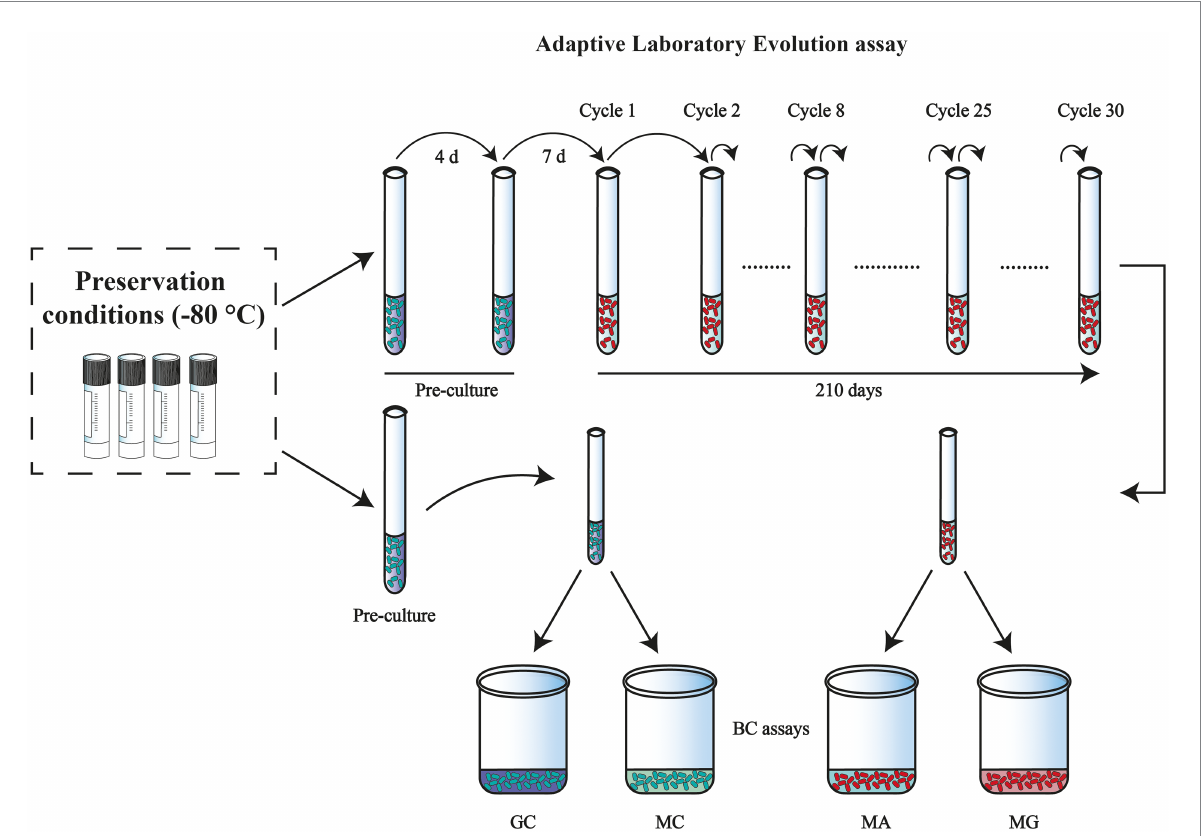
FIGURE 1 Overview of the experimental design: adaptation induction of Komagataeibacter xylinus K2G30 in mannitol medium. Preculture was maintained in HS-G and adaptation of the strain in mannitol medium begins from cycle 1. Both the adapted and the parental strain were tested for BC quantification and each color represents a different condition: MA (adapted in mannitol medium), MG (adapted strain in glucose medium), GC (parental strain in glucose medium), and MC (parental strain in mannitol